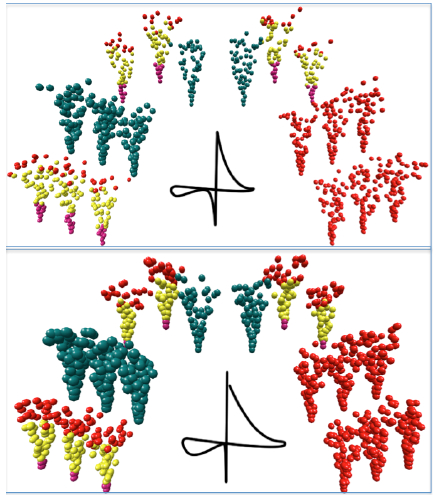
Fig. 12: Animation of the particle emitters, controlled by the Leap Motion : amplitude of the conductor’s movement and the associated